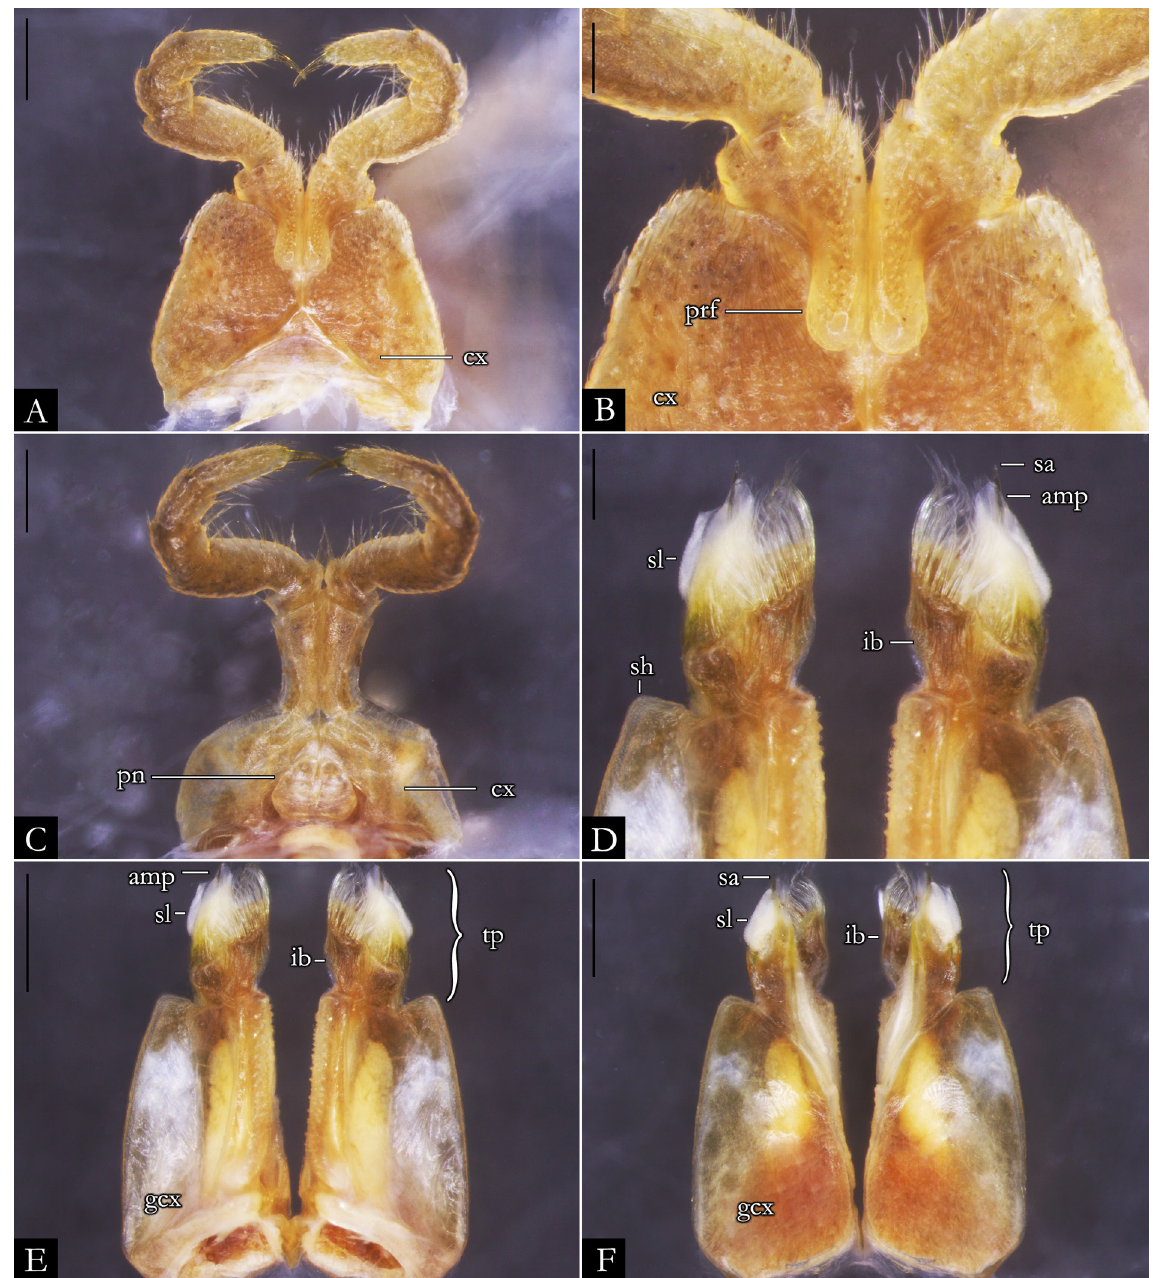
Fig. 88. Pseudonannolene magna Udulutsch & Pietrobon, 2003, paratype, ♂ (MZSP 941). A . First leg- pair. B . Detail of prefemur. C . Second leg-pair. D . Detail of telopodites, in anal view. E . Gonopods, in anal view. F . Gonopods, in oral view. Abbreviations: see Material and methods. Scale bars: A, C, E–F = 0.5 mm; B, D = 0.2